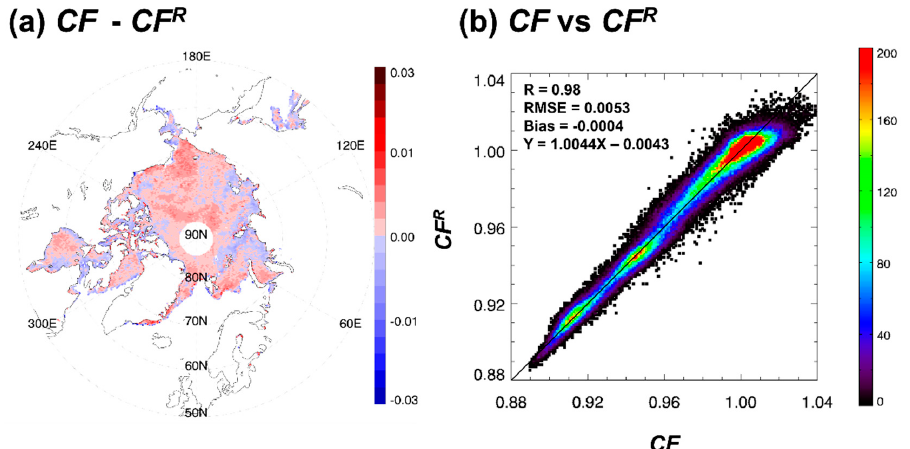
Table 2. Correlation coefficients between directly obtained CF and modeled CF R for each year.